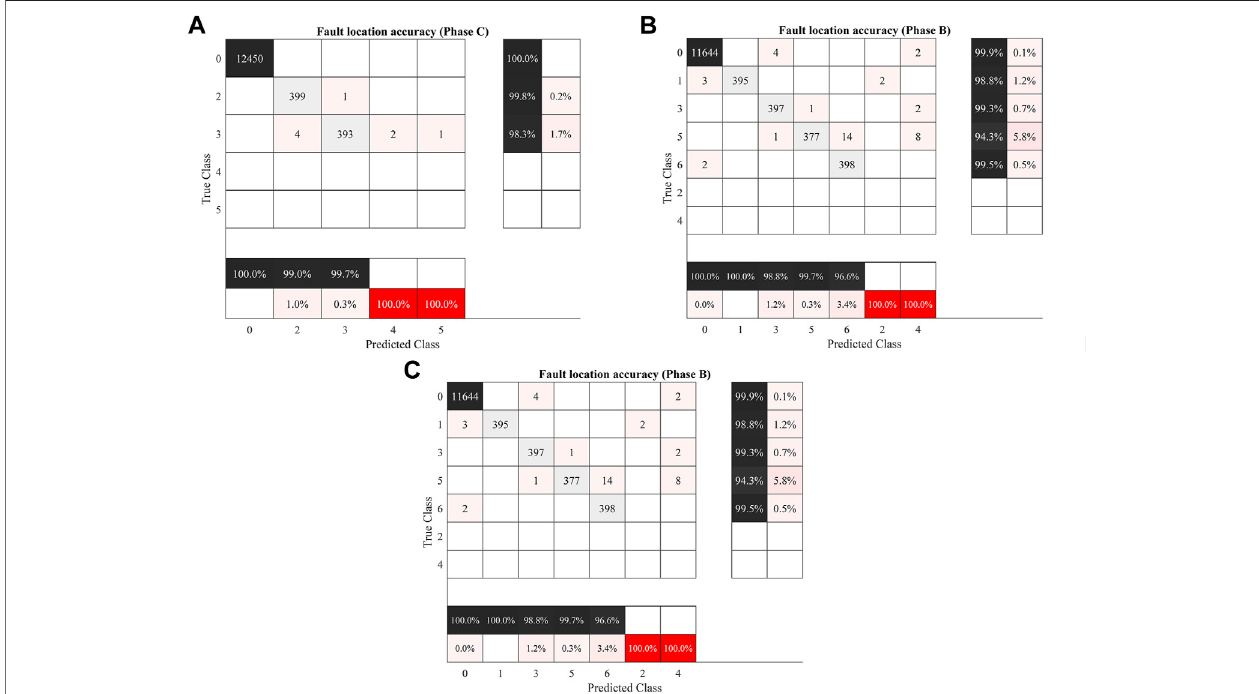
FIGURE 12 | Confusion chart for locating faults involving (A) Phase A, (B) Phase B, and (C) Phase C.